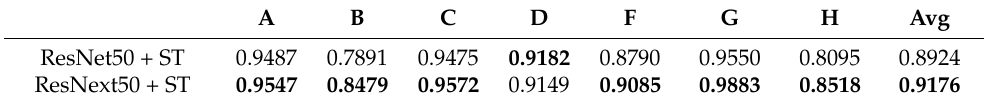
Table 3. F1 -score with different classifications networks (bold means the best result).